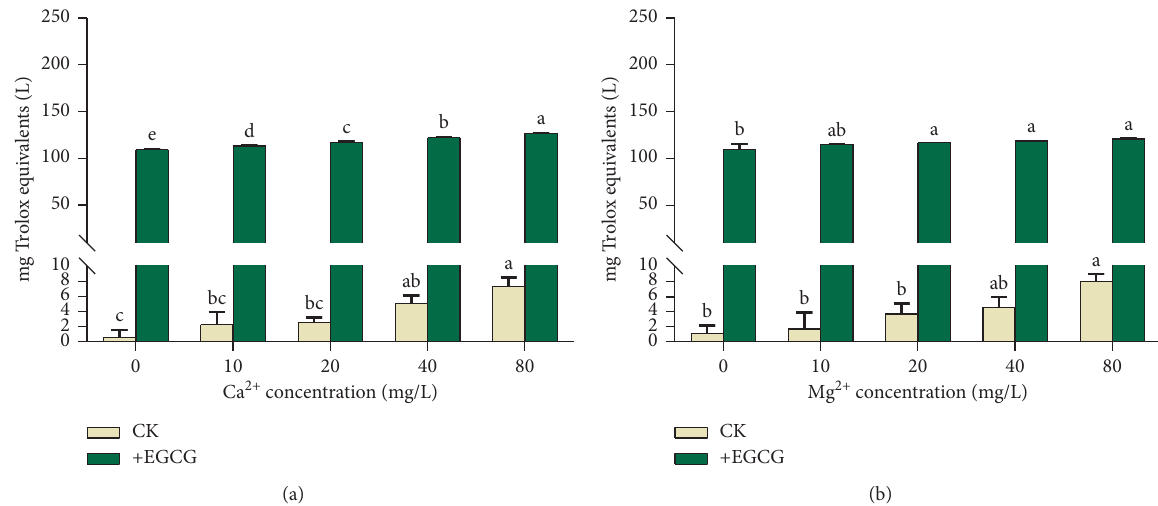
Figure 4: Effect of Ca 2+ (a) and Mg 2+ (b) with different concentrations on the antioxidant activity of EGCG solutions of 50mg/L. CK: control check, ion solution without EGCG; +EGCG: ion solution with EGCG. a,b,c,d Different letters above the column indicate significant differences among different concentrations of ions ( p < 0 .